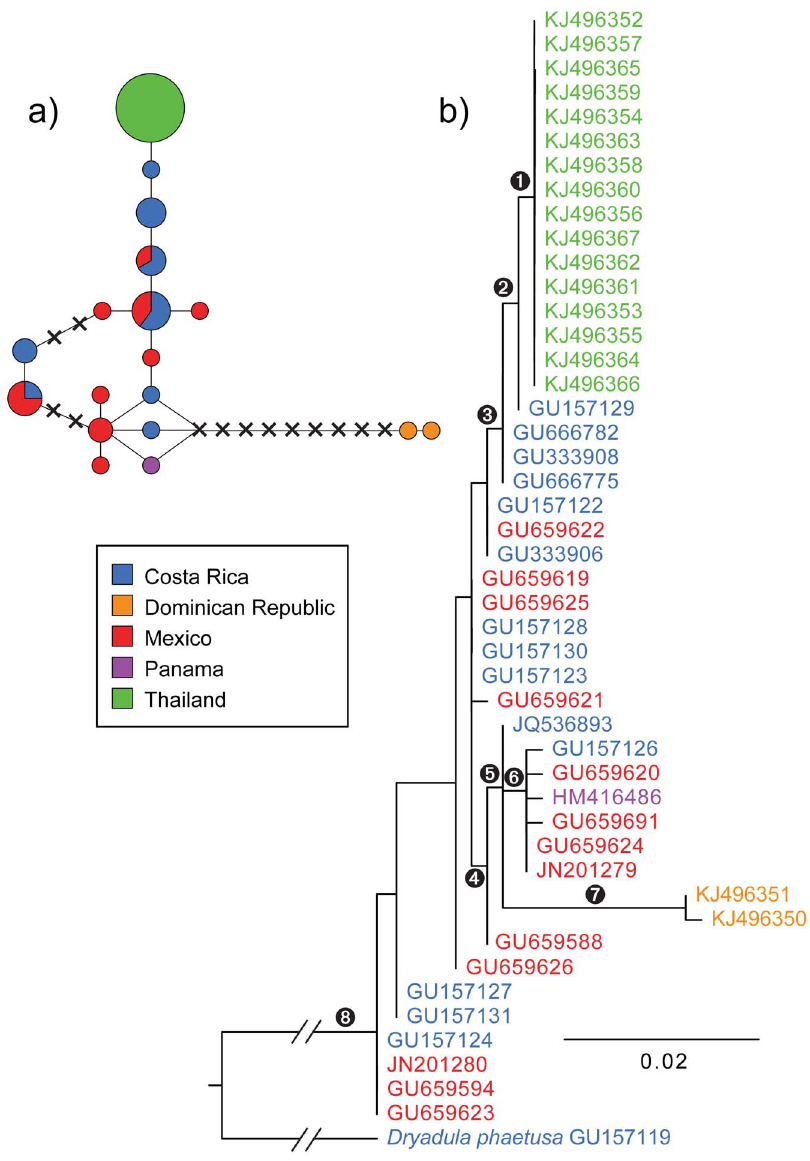
Figure 2. Relationships among Dryasiulia showing that wild-caught, Thai specimens have identical barcodes with specimens from the Phuket Butterfly Garden and no other samples collected in Central America and the Caribbean. a) Most parsimonious haplotype network of D. iulia constructed with 95% connection limit. The size of each circle is proportional to the number of specimens sharing that haplotype; the smallest circles represent a single haplotype and the largest, sixteen. The colors of the pie charts indicate proportional representation of the provenance of samples with that haplotype. Separation by a line indicates a single base pair difference between haplotypes; crosses represent haplotypes that would be 1 bp different than adjacent haplotypes, but were not sampled in this study. b) maximum likelihood bootstrap consensus tree of COI haplotypes from D. iulia and one outgroup. Codes refer to GenBank Accession Numbers and colors denote provenance of specimen collection. Numbers near selected nodes indicate refer to the following branch support values (maximum likelihood bootstrap support, Bayes posterior probability, parsimony bootstrap support,